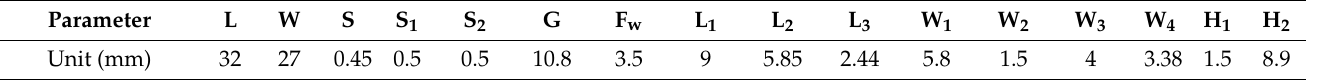
Table 1. Optimized dimensions of the proposed